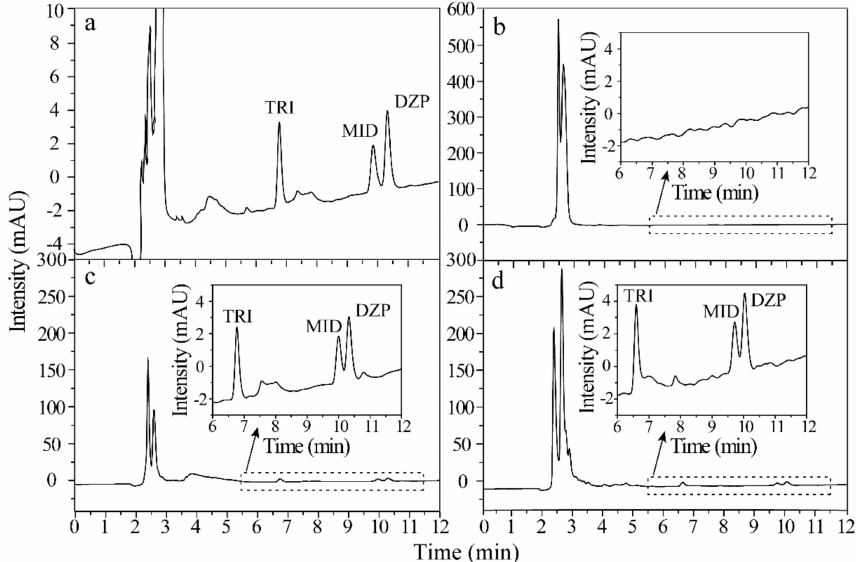
Figure 6. Chromatograms of ( a–d ) BZDs in the standard solution (300 ng/mL of each analyte), spiked urine sample (10 ng/mL of each analyte) with direct injection, pretreated by ZIF-8@Dt-COOH(2 × ) SPE cartridge and pretreated by commercial CX SPE adsorbents.